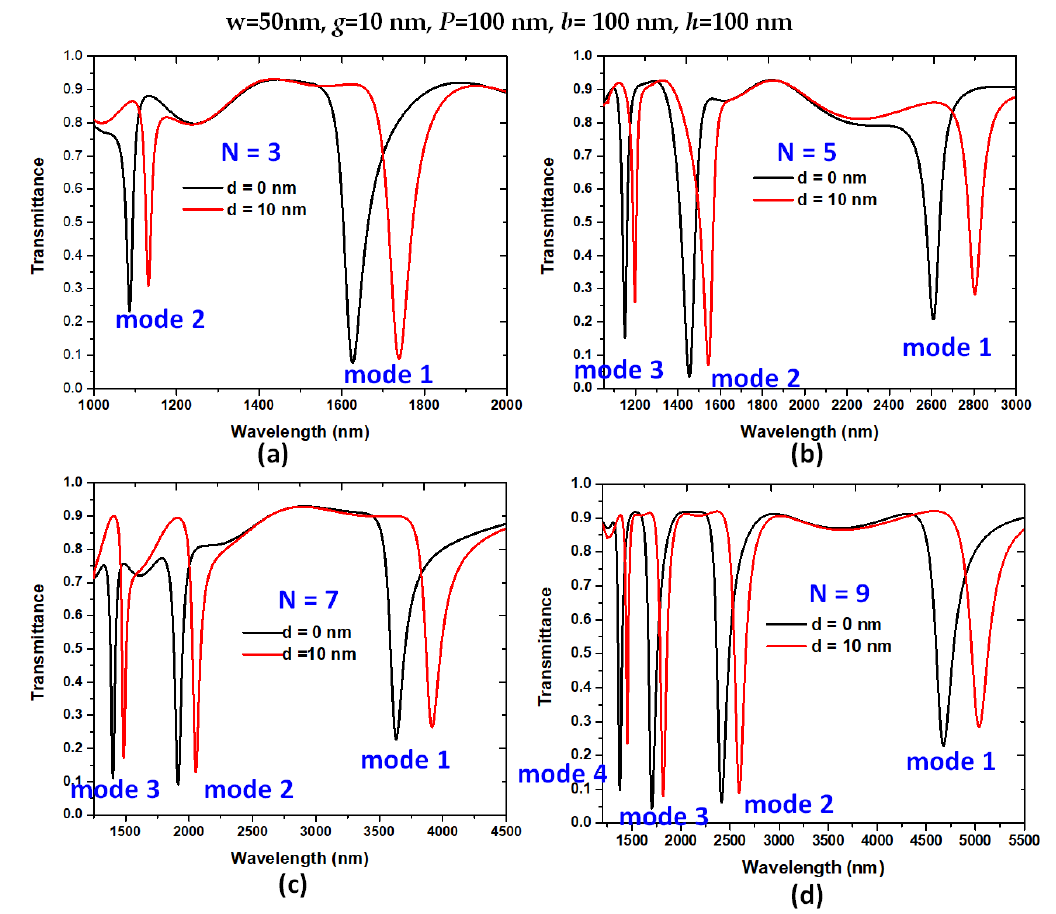
Figure 8. Transmittance spectra of the designed structure with a variation of the number of stubs ( N ), ( a ) N = 3, ( b ) N = 5, ( c ) N = 7, and ( d ) N = 9, respectively.